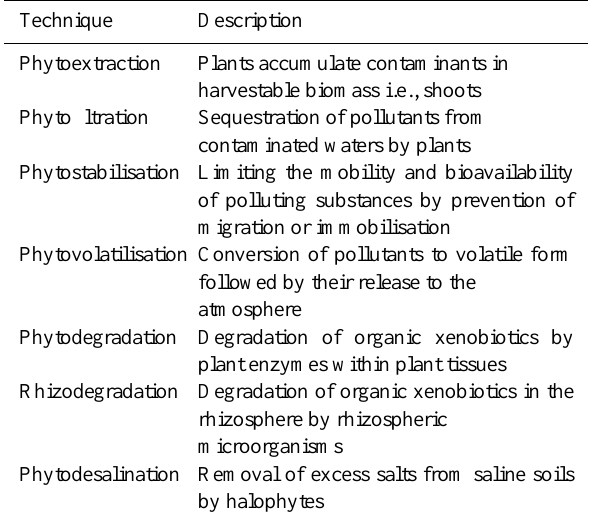
Table 3. Summary of the different techniques of